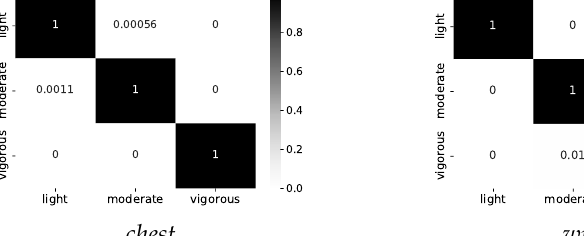
Figure 10. Confusion matrices for detecting the intensity of the activity.